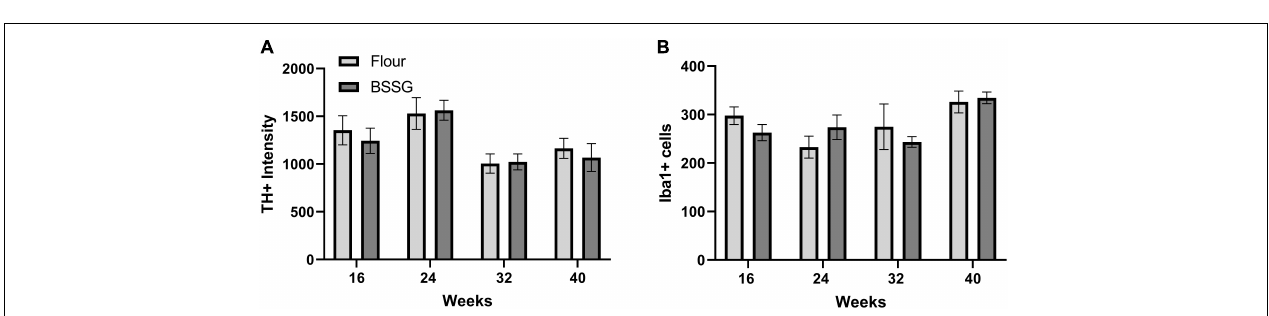
FIGURE 6 | Assessment of USVs. (A) Total number of USVs and (B) Duration of USVs. Data are shown as means ± SEM, n = 4–5.